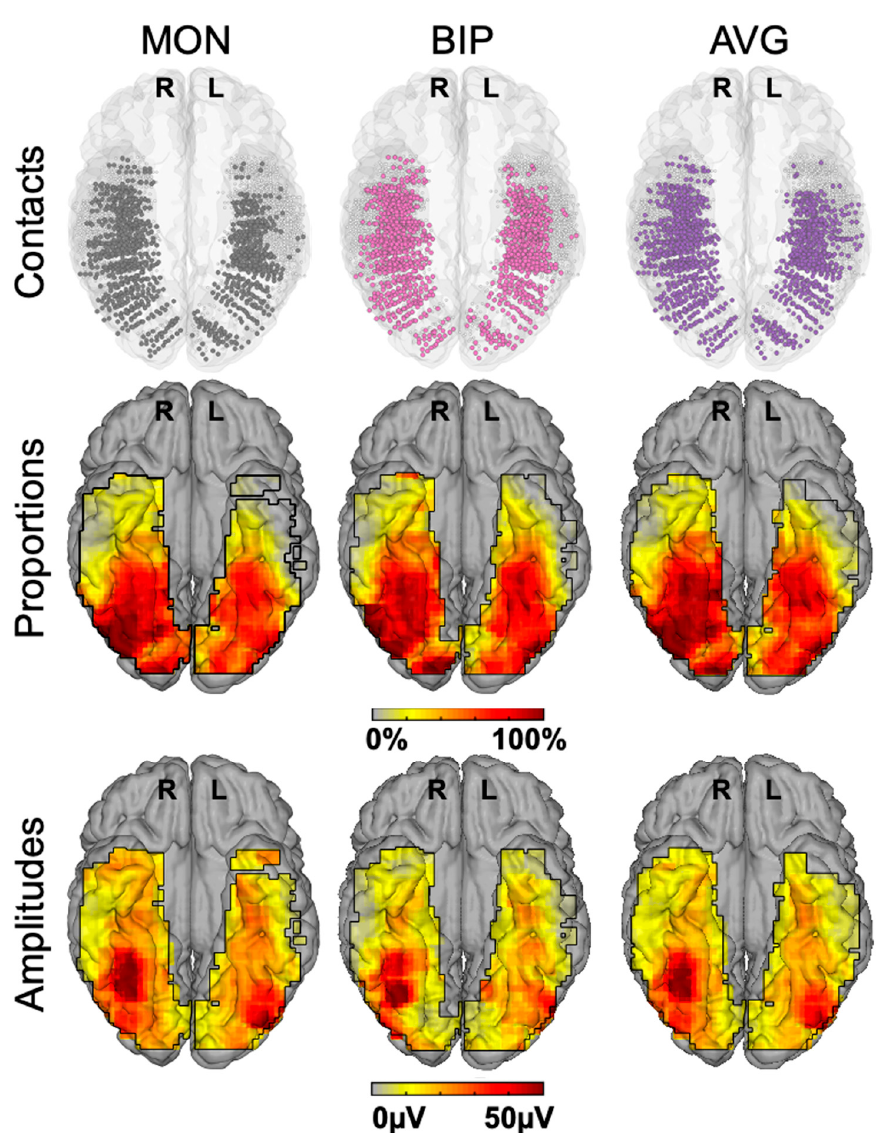
Figure 19. Face-selective maps are largely similar across reference montages (Hagen et al., in preparation) (MON: scalp electrode or intracerebral white-matter contact, BIP: bipolar montage; AVG: common average reference). Top : maps of all 5268 VOTC recording contacts across the 93 individual brains displayed in the Talairach space using a transparent reconstructed cortical surface of the Colin27 brain. Each circle represents a single contact, with colored-filled circles corresponding to selective contacts and gray-filled circles corresponding to non-selective contacts. Middle and bottom : Proportion and amplitude maps. Black contours outline proportions and amplitude significantly above zero.